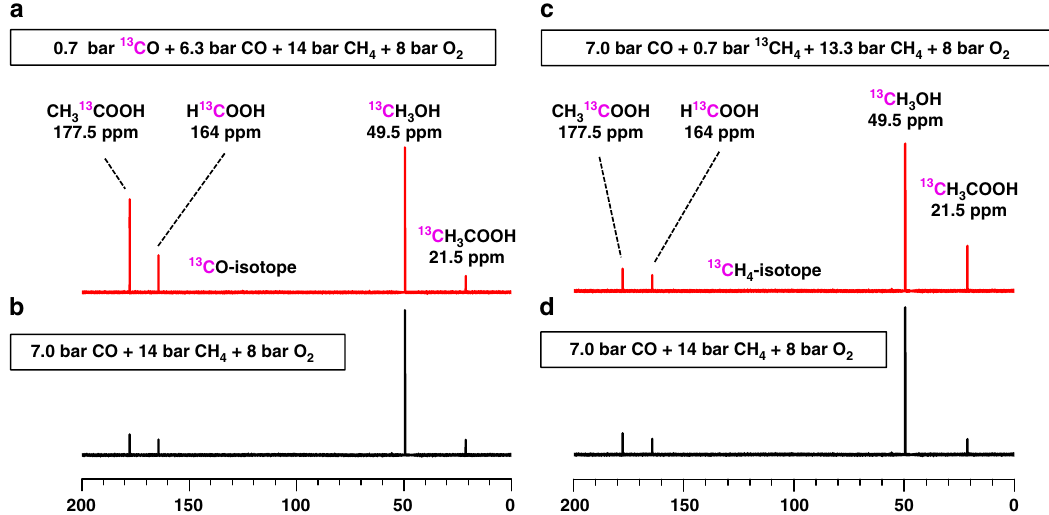
Fig. 4 13 C NMR studies of reaction using 13 CO or 13 CH 4 . 13 C NMR spectra of products of acetic acid, formic acid, and methanol on 28 mg 0.10 wt%Rh/ ZSM-5 at 170 °C for 10 h in gas of a mixture of 0.7 bar 13 CO, 6.3 bar CO, 14 bar CH 4, and 8 bar O 2 , b mixture of 7 bar CO, 14 bar CH 4 , and 8 bar O 2 , c mixture of 7 bar CO, 0.7 bar 13 CH 4 , 13.3 bar CH 4 , and 8 bar O 2 , and d mixture of 7 bar CO, 14 bar CH 4 , and 8 bar O 2 . a and b are isotope experiments; c and d are their corresponding contrast